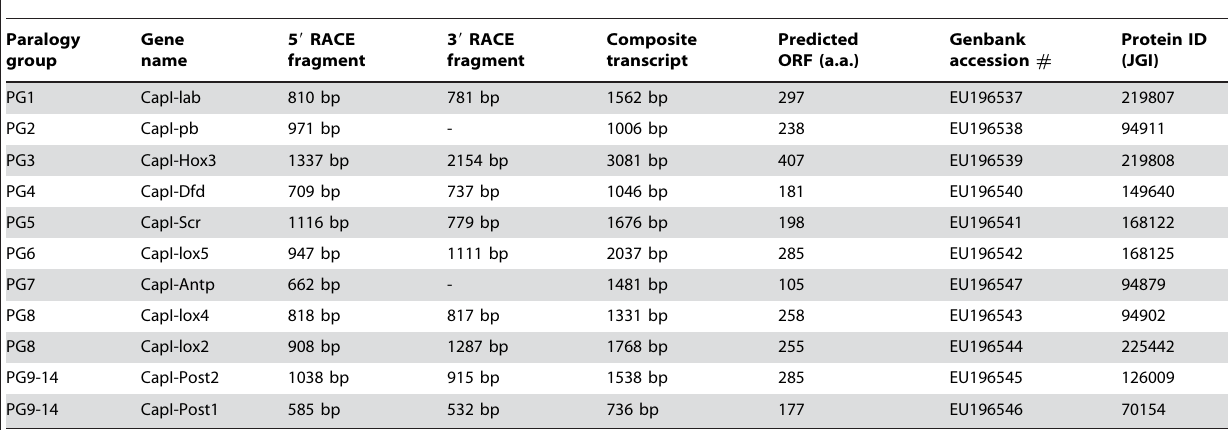
Table 1. Capitella sp. I Hox